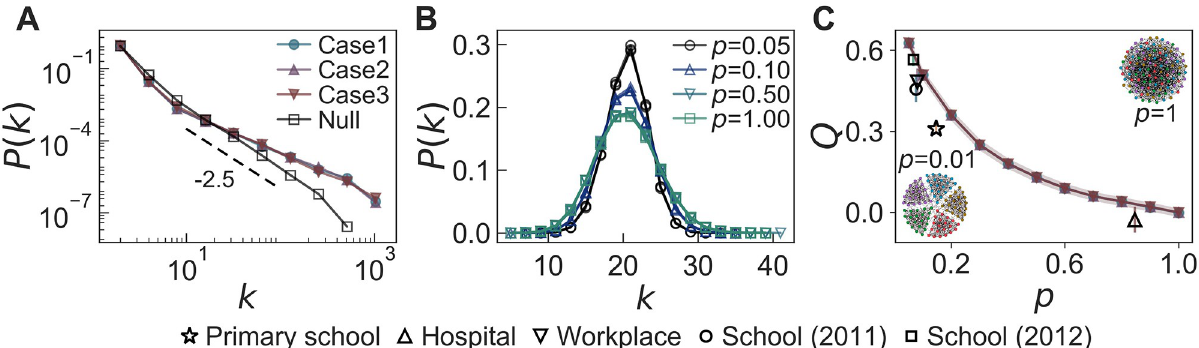
Fig 9. Simulation results of the temporal network model considering heterogeneous activities of nodes or the community property. (A) The networks are generated with F ( a ) * a − 2.5 and N = 10 4 , and the other parameters are the same as in Fig 8. (B) and (C) The networks are generated with N c = 5 in the same parameter settings as in Fig 8. In the panels (A) and (B), degree distributions P ( k )s are logarithmically and linearly binned, respectively. In the panel (C), the modularity Q is shown for various p . Each empty marker presents the empirical result for the primary school ( ✰ ), hospital ( 4 ), workplace ( 5 ), school (2011) ( � ), and school (2012) ( □